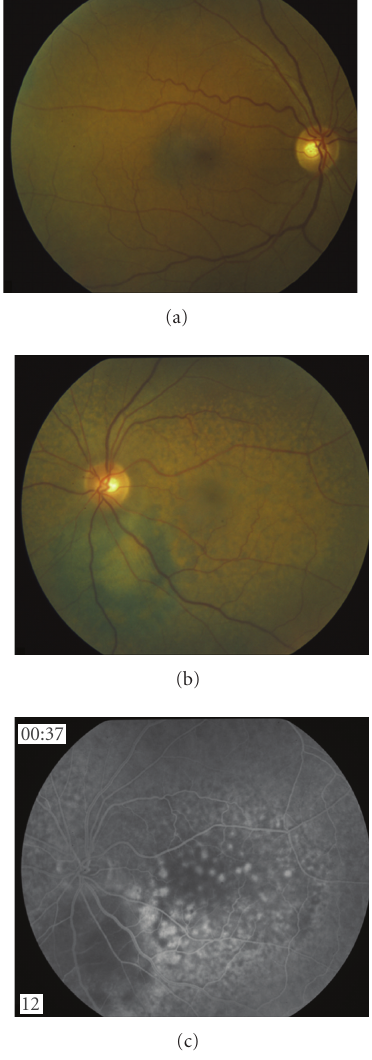
Figure 2: The right fundus is unremarkable. Left eye, six months after radioactive iodine treatment: fine, patchy, pigmentary changes throughout the posterior pole with an unchanged appearance of the original pigmented lesion. Fluorescein angiography shows blocking of the original lesion and fine hyperfluorescence corresponding to the areas with pigmentary change on fundus